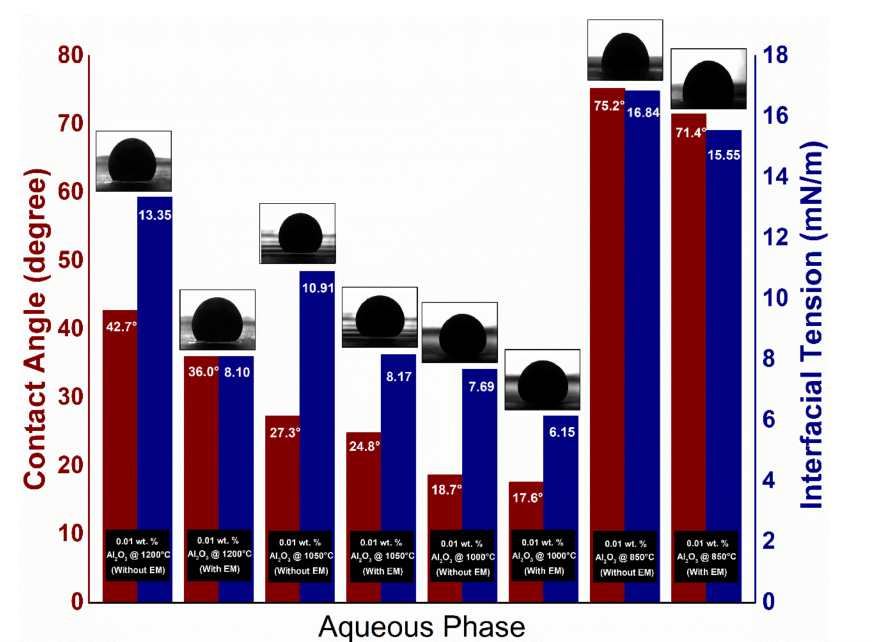
Figure 9. IFT and contact angle of the oil droplet using Al 2 O 3 nanofluids under the EM field. Source: M. Adil, et al. [60] reprinted with